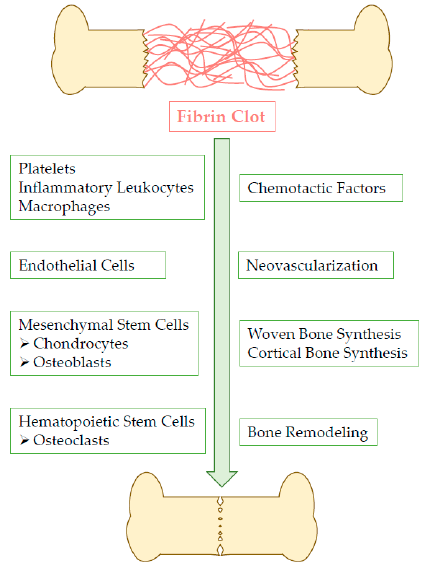
Figure 1. Fibrin clot-induced physiological bone healing cascade [4].